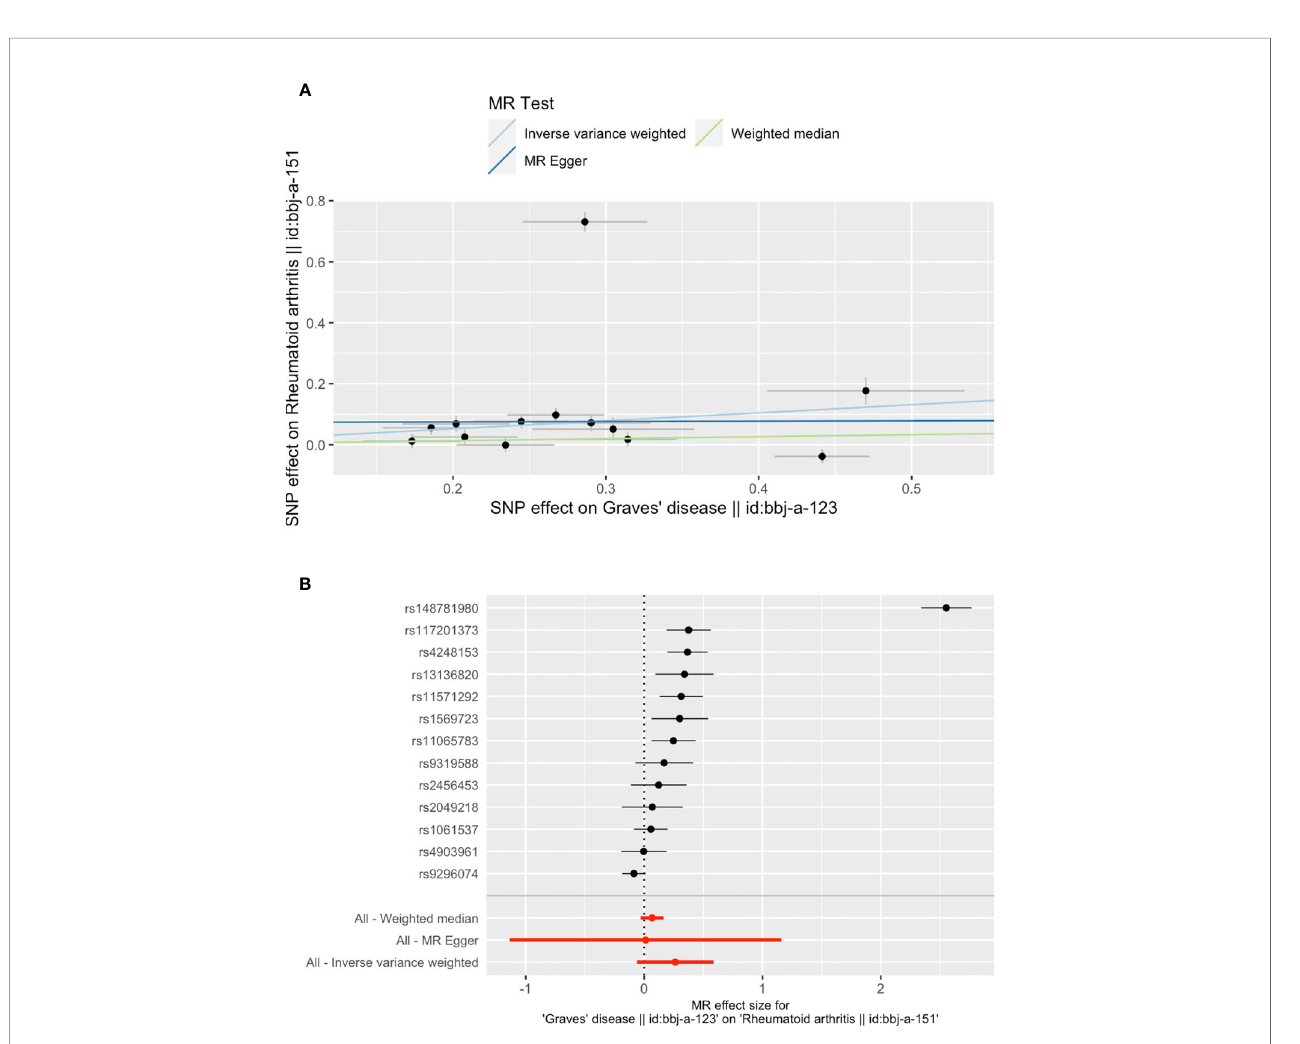
FIGURE 4 | Plots of Mendelian randomization (MR) estimates of the causal relationship between Graves ’ disease (GD) and rheumatoid arthritis (RA). The log odds ratio of risk is demonstrated, and three different methods [inverse variance weighted (IVW) approach, MR-Egger, and weighted median] were used. (A) The scattered plot of SNPs associated with GD and their risk on RA. (B) Forest plot of SNPs associated with GD and their risk on RA (rs148781980 plays a dominant role). SNPs, single nucleotide